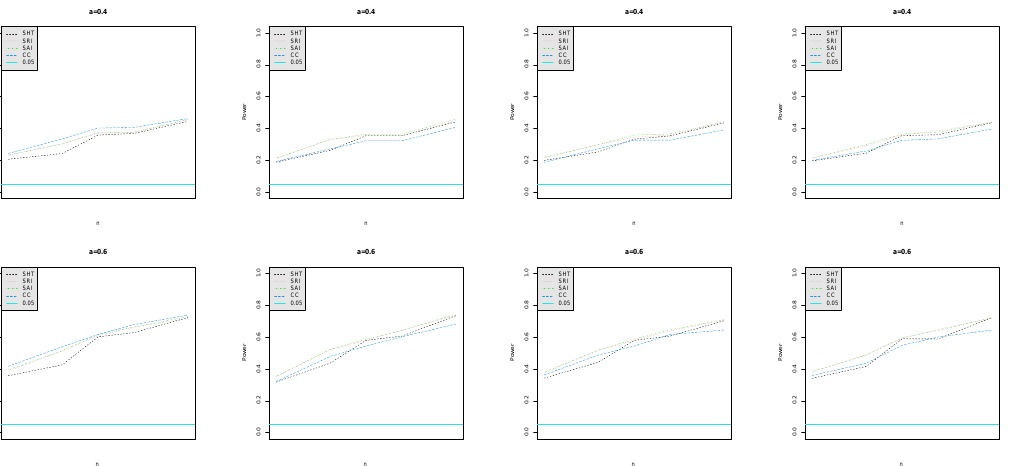
Figure A3. SHT, SRI, SAI and CC represent empirical powers evaluated from IPW, regression imputation, AIPW and CC methods against the sample size n for missingness data mechanism models E1 (left panel), E2 (left second panel), E3 (right second panel) and E4 (right panel) for a = 0.4 (upper row) and 0.6 (lower row) under balanced